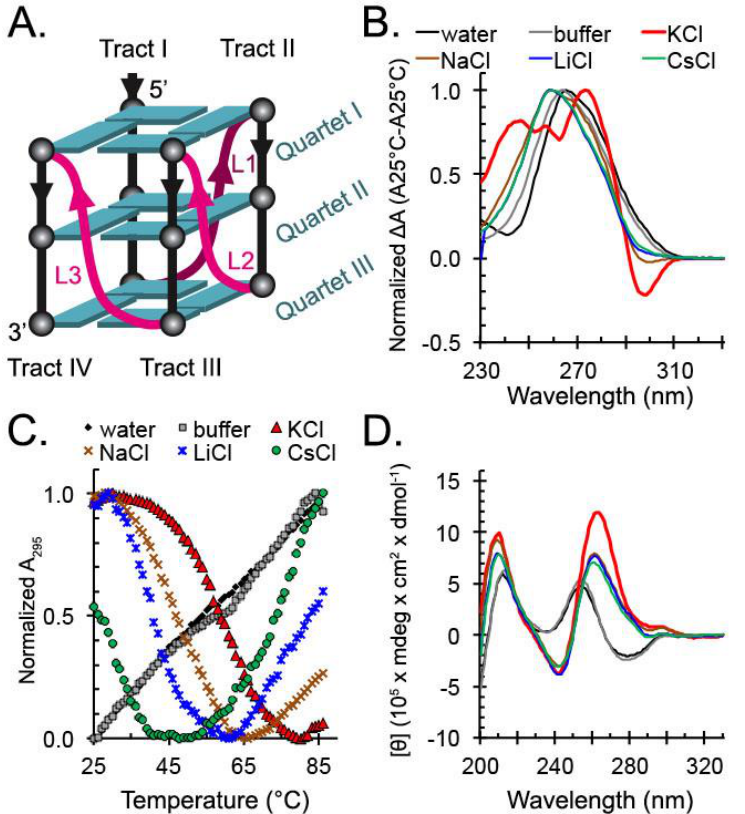
Figure 1. Spectroscopic analysis of a G-quadruplex (G4) formation by hex4 _A5U. Oligonucleotides annealed in water (black), 10 mM tetrabutyl ammonium phosphate (TBA) buffer pH 7.5 (gray), or 10 mM TBA buffer supplemented with 100 mM of KCl (red), NaCl (brown), LiCl (blue), or CsCl (green). ( A ) Schematic representation of a canonical parallel unimolecular G4. Four tracts of three consecutive guanines (spheres) form three stacked G-quartets (cyan) stabilized by a monovalent cation. L1, L2, and L3 are lateral loops (magenta). ( B ) Normalized thermal difference spectra show formation of G4s, indicated by a negative peak at 295 nm. A prominent negative peak is observed only in KCl, and is absent in water or buffer, with intermediate values observed for NaCl, LiCl, and CsCl. ( C ) Thermal melting measured the cation-dependent stability of the G4 structures. G4s formed in KCl were the most stable, with a T 1/2 of 58 °C, followed by 50 °C for NaCl, 42 °C for LiCl, and <30 °C for CsCl. A linear increase in absorbance at 295 nm for oligonucleotides annealed in the absence of cation indicates that no G4 structures formed. ( D ) Circular Dichroism (CD) spectra show the formation of parallel G4s in the presence of cations. Peak maxima at 262 nm and minima at 242 nm were the hallmarks of the parallel G4s and were observed in KCl, NaCl, LiCl, and CsCl.